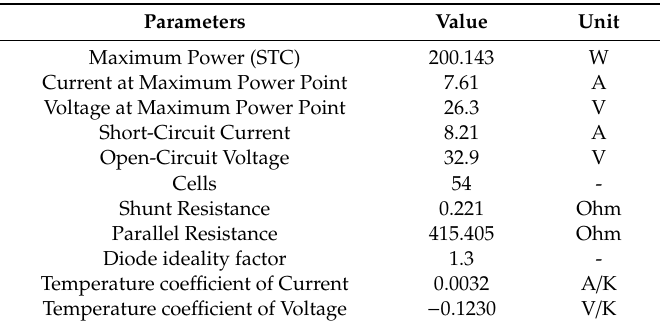
Table A1. Parameters of the PV module.